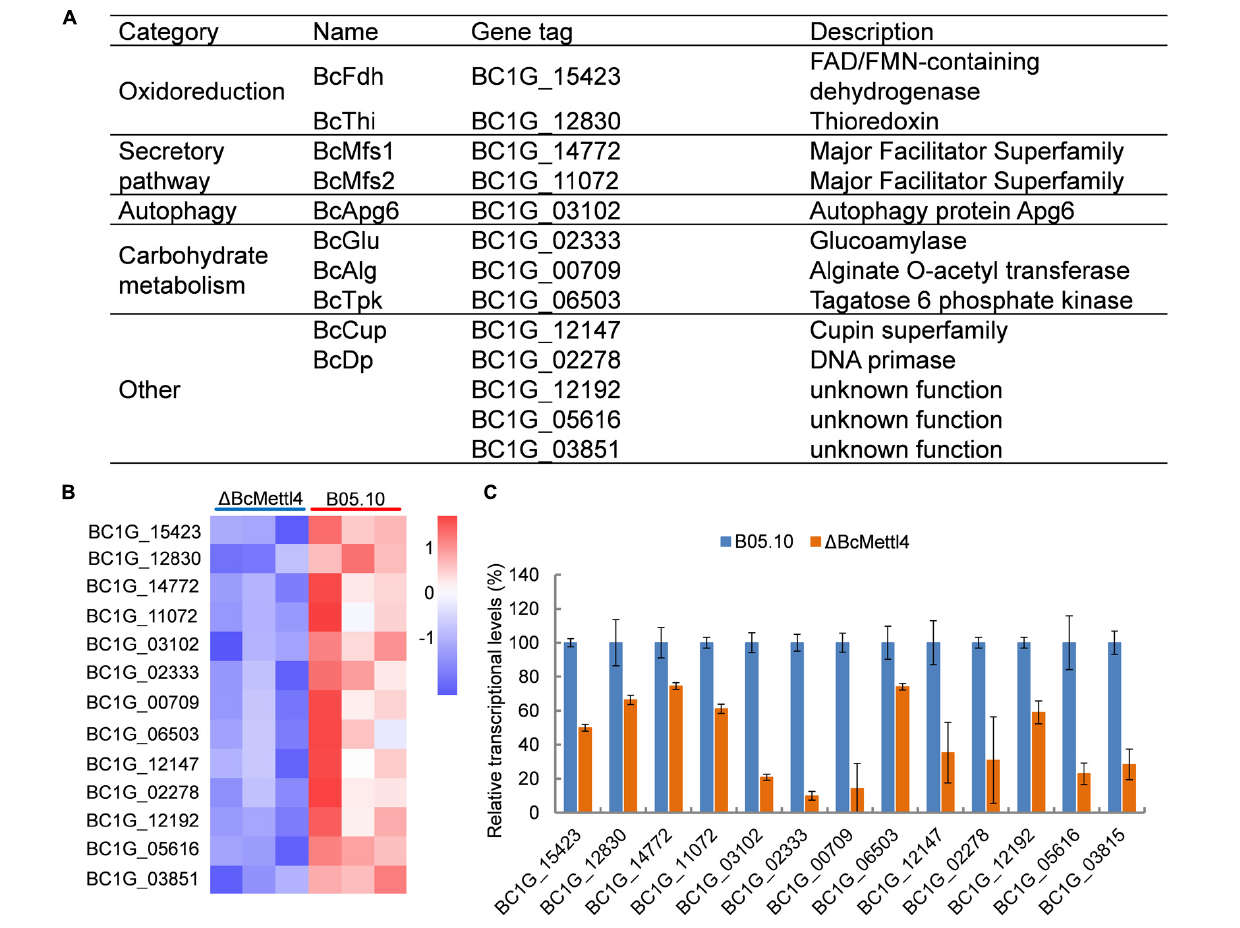
is a widespread DNA modification in the B. cinerea